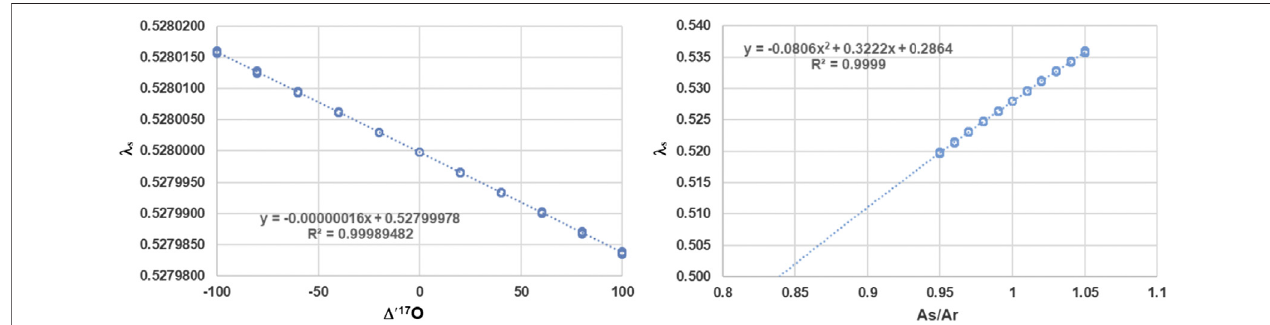
FIGURE1| Leftpanel:Dependenceof λ s on Δ ′ 17 O .Theslightlyblurredopencirclestowardmorenegativeandmorepositivevaluescorrespondstothe 18 R s .Right panel: Dependence of λ onratio A s / A r .Theslightlyblurred opencirclesinbothpanelscorrespondtotheotherdependencesof Δ ′ 17 O and 18 R s intherangeof[-100,100] per meg or per mil, respectively. The dashed lines correspond to regressions (linear or quadratic) of the dependencies given with corresponding equations and R 2 .